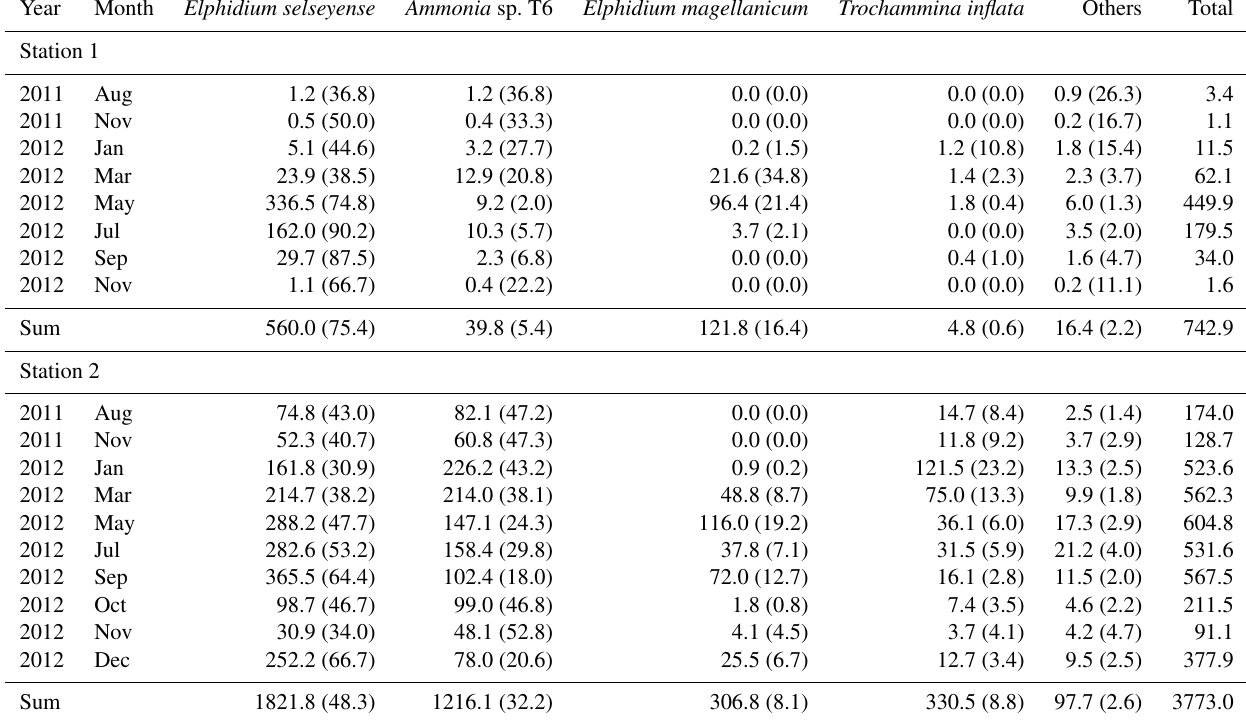
Table 2. Mean living foraminiferal absolute (ind. 10cm − 3 ) and relative abundances (percentage of the total fauna, in parentheses) of the dominant species. Last column: absolute abundance of the total